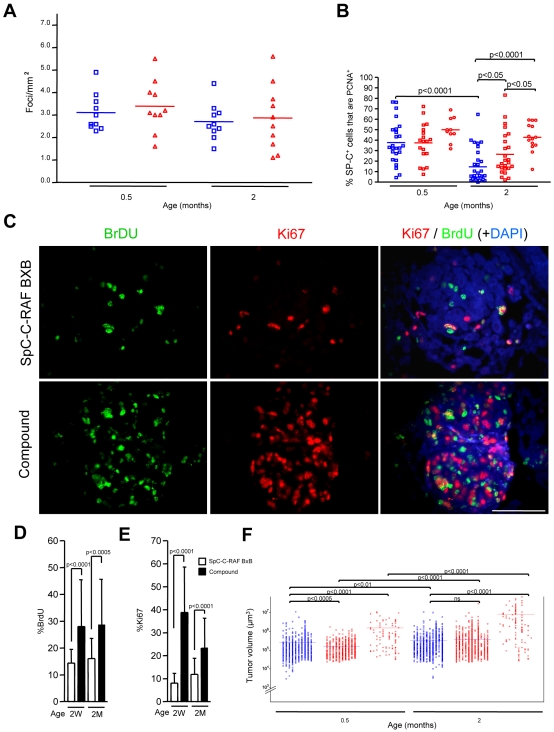
C-RAF and c-MYC cooperate in lung tumor acceleration but not in tumor incidence.(A) Tumor incidence in SpC-C-RAF BxB (blue open squares) and compound mice (red open triangle). Each symbol represents one lung. Values were normalised for lung size to compensate for age differences. There is no significant difference between the means. (B) Percentage of pro SP-C positive cells that are PCNA positive. Values represent SD of the mean. Genotypes and tumor categories are indicated as follows: SpC-C-RAF BxB cuboidal (blue open squares), compound cuboidal (red open squares) and compound columnar (red open circles). Each symbol represents one tumor. (C) Two weeks and two months old mice were injected daily with BrDU during one week and chased for one day. Paraffin embedded lung sections from SpC-C-RAF BxB single transgenic and compound mice were double stained for BrDU (green) and Ki67 (red) to identify cells in cycle. Dapi staining highlights lung tumors. Scale Bar: 100 µm. (D, E) Percentage of BrDU and Ki67 positive cells in tumors from both genotypes at different ages. 30 tumors from 3 mice were analysed per genotype. Values represent SD of the mean. (F) Tumor volume was computed by measuring tumor area assuming spherical shape of tumors. Symbols represent individual tumors. Each column represents one mouse. Genotypes and tumor categories are as described in B. All the tumors from each category were compared between genotypes. Values represent SD of the mean. Statistical differences between groups as indicated. ns: Not significant